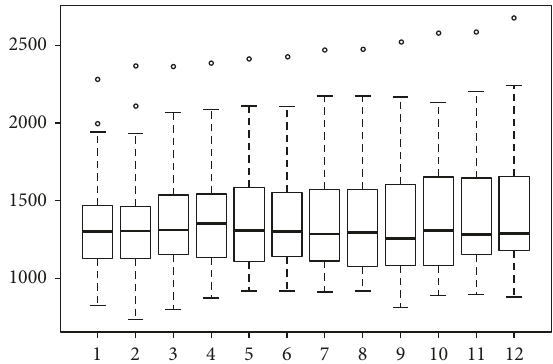
Figure 2: Annual variation of monthly DGD (1998-2017).